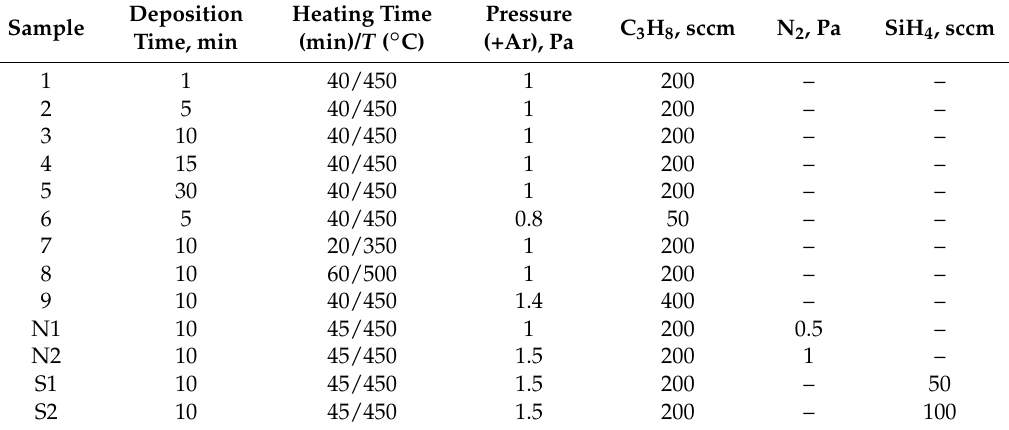
Figure 1. ( A ) Schematic illustration of the ICP CVD roll-to-roll apparatus for the mass production of VOG coating on a moving copper foil substrate. This technology enables preparation of an electrode with a VOG grown at lower processing temperature by using a radio frequency (RF) generator and a matching block (MB) as a plasma source; ( B ) True color photo images of the VOG-coated copper foil being prepared by using this technology (deposition time: 10 min, heating time/temperature: 40 min/450 ◦ C, total pressure of {C 3 H 8 + Ar} gas mixture: 1 Pa; ( C , D ) representative FE-SEM images of this VOG coating. Red arrows show surface defects of the copper foil, which occurred after industrial manufacturing. Table 1. Technological parameters of the ICP CVD roll-to-roll technology for the preparation of vertically oriented graphene nanostructures in various gas mixtures.